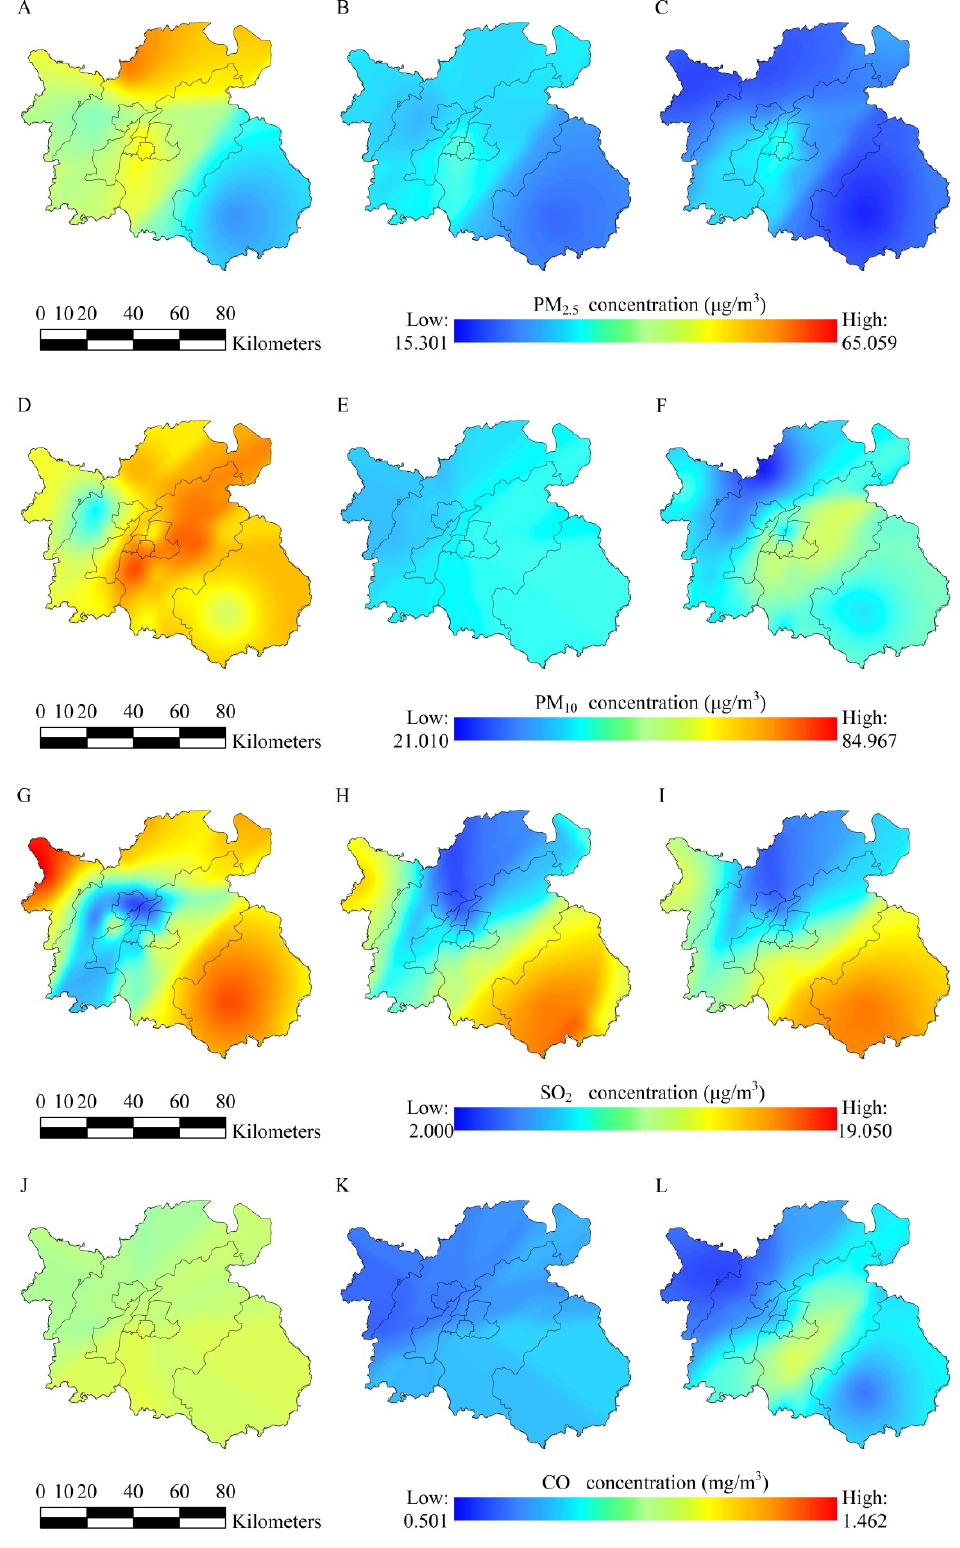
Figure 8. Spatial distribution of PM 2.5 , PM 10 , SO 2 , and CO concentrations in ( A , D , G , J ) (before COVID-19), ( B , E , H , K ) (during COVID-19), and ( C , F , I , L ) (after COVID-19) periods over Nanchang.